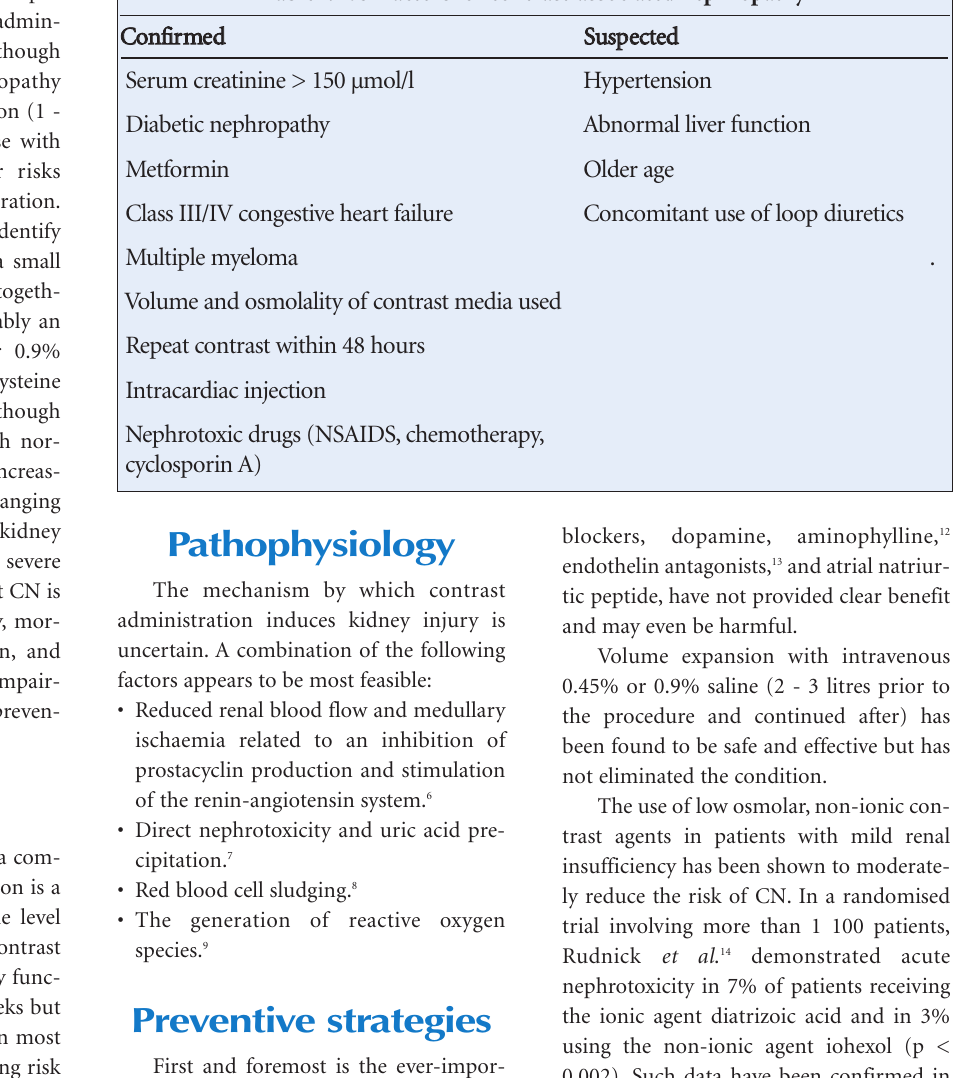
Table I.Risk factors for contrast-associated